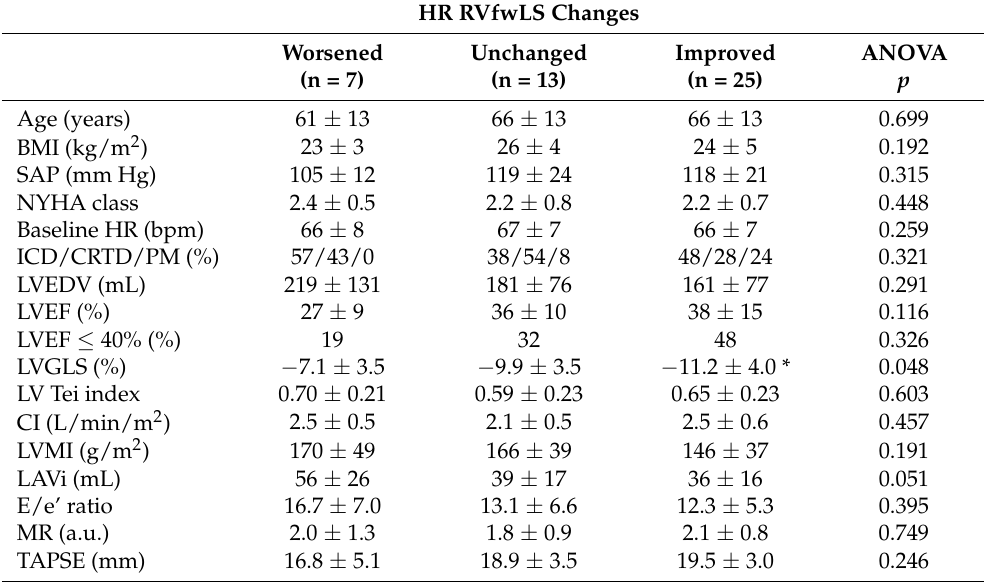
Table 4. HR-dependent changes in